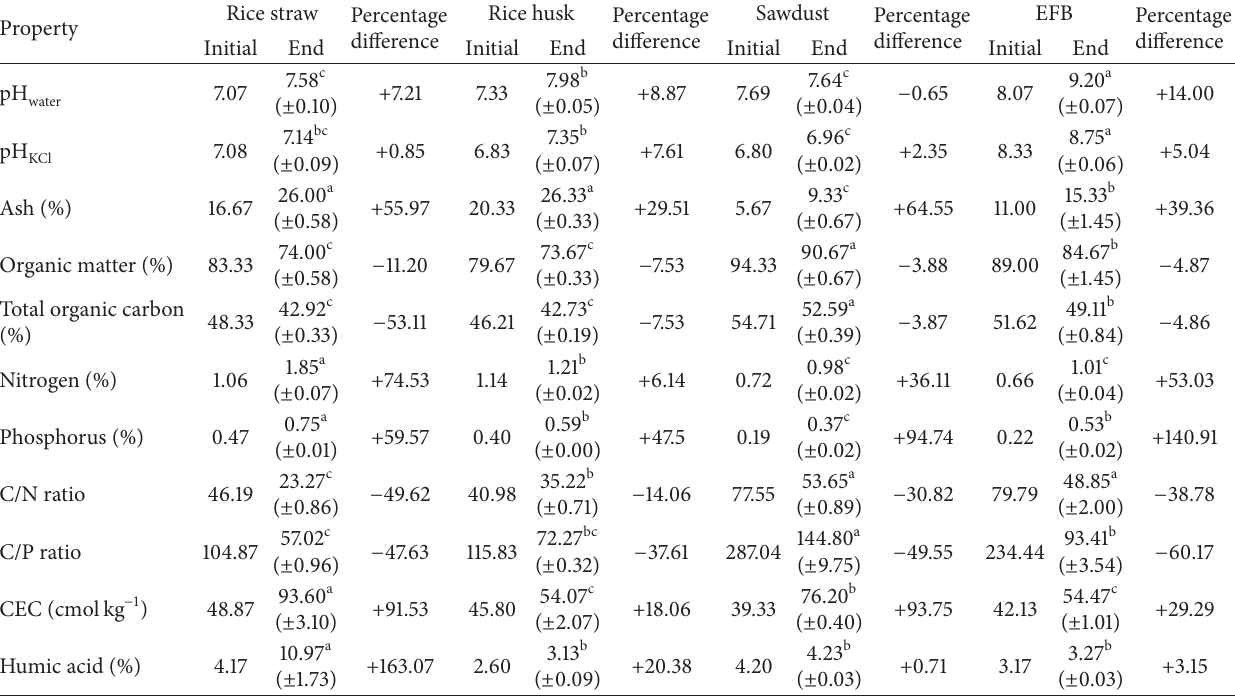
Table 3: Chemical properties of different composts at initial and final stages of composting.